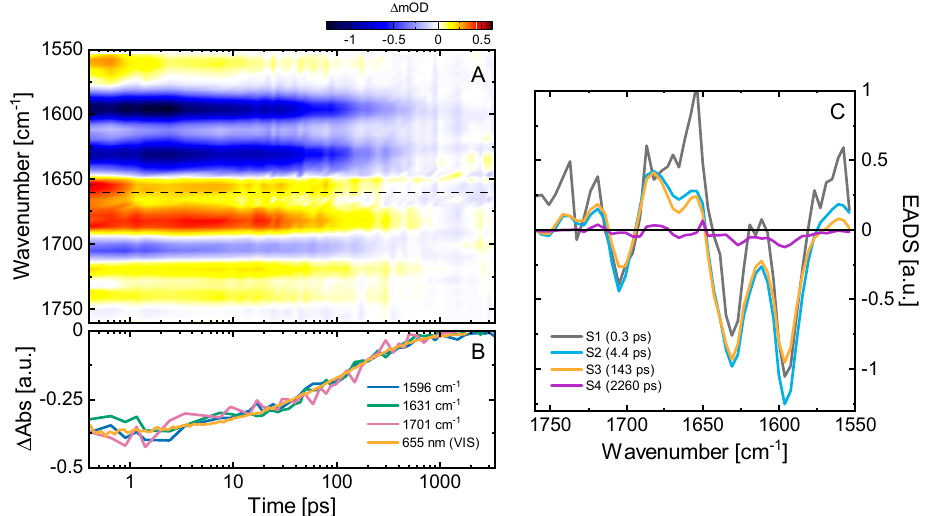
Figure 3. Ultrafast excited state dynamics of the P r state in Syn Cph2 investigated in the IR spectral range. ( A ) TA data of the P r → P fr dynamics after excitation at 640 nm. The signal sizes in the C=O region were multiplied by a factor of 2 to account for the lower excitation density used as compared to the data of the C=C region. The transition between these regions is indicated by the dashed black line. ( B ) Scaled transients at selected wavenumbers in comparison to a transient from the GSB of the corresponding vis pump-probe measurements (Figure 2A). ( C ) Evolution-associated difference spectra (EADS) obtained from a sequential model fit of the transient vis pump-IR probe data of the P r dynamics.